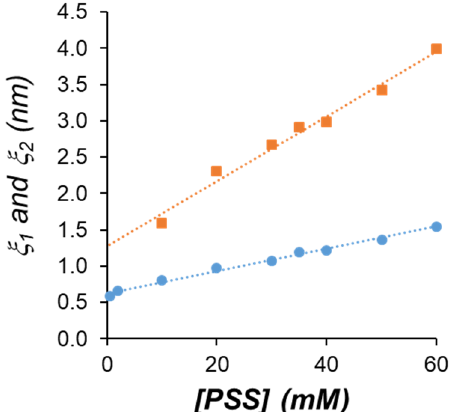
Figure 8. Correlation lengths ξ 1 (circles) and ξ 2 (squares) obtained from Equations (10) and (11), respectively. Linear regression functions are y = 0.0153 + 0.6238 ( R 2 = 0.99) for ξ 1 vs. [PSS] and y = 0.0447 + 1.2751 ( R 2 = 0.98) for ξ 2 vs. [PSS].